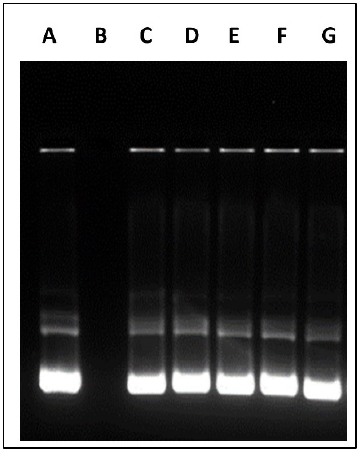
Figure 4. DNase protecting effect of different polymeric micelles containing pVGF. Column A ) Un- treated pVGF, column B ) pVGF treated with DNase, column C ) CS–pVGF column D ) OA-g-CS– pVGF, column E ) OA-g-CS-Man–pVGF, column F ) OA-g-CS-Tat–pVGF, Column G ) OA-g-CS-Man- Tat–pVGF.